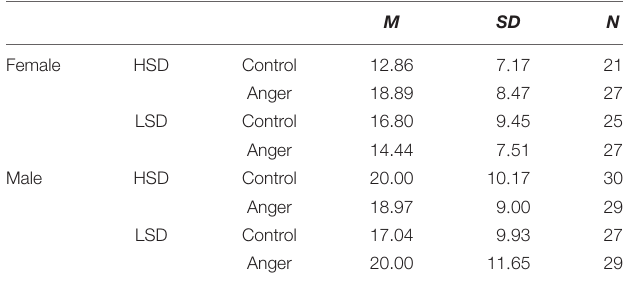
FIGURE 1 | Anger rating of the AEMT in the angry and control condition in Study 1. The error bar is the Standard error.